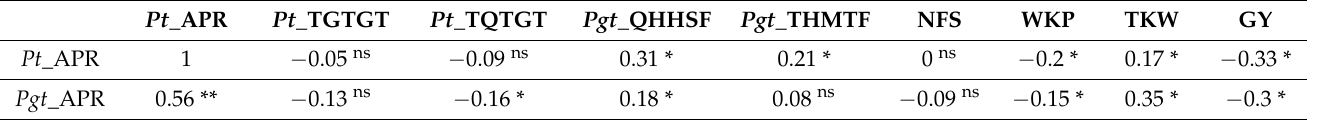
Table 6. Correlations among adult plant resistance to Pt and Pgt and yield components in the field of Karabalyk agricultural experimental station and seedling resistance under greenhouse conditions.